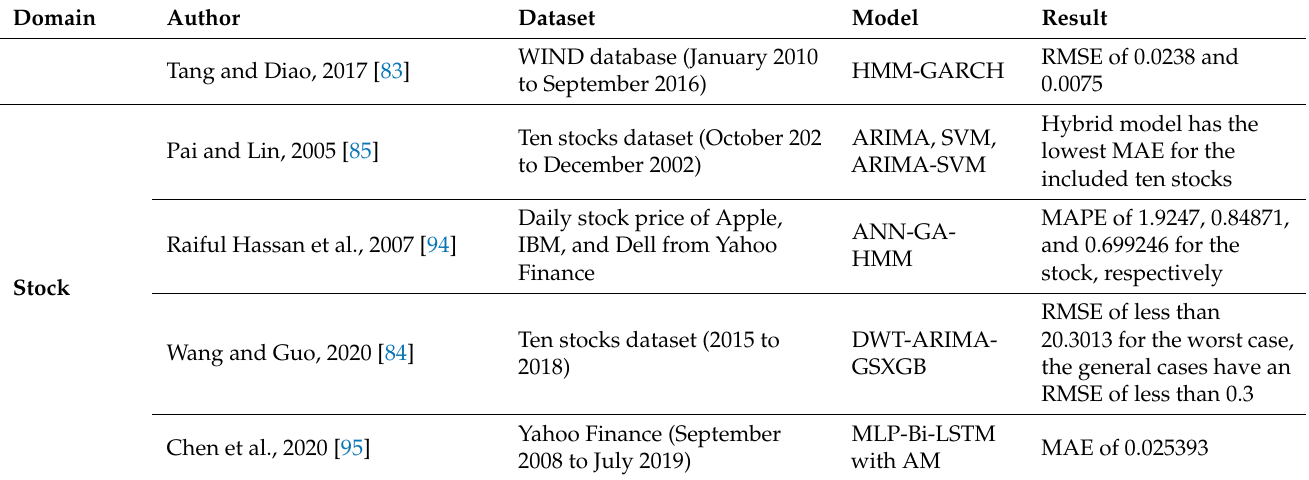
Table 9. Hybrid model time-series forecasting from 2004 to